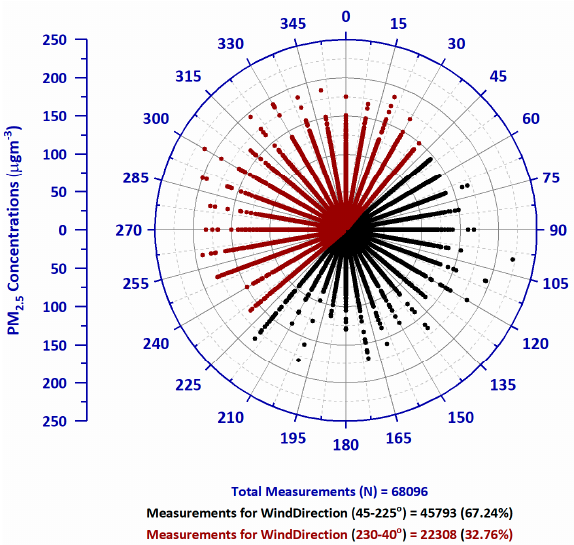
Figure 6. Hourly PM 2.5 concentrations from all air quality monitoring stations including Central, Tap Mun, Tsuen Wan, Yuen Long, and Tung Chung as a function of corresponding hourly surface wind direction in Hong Kong (2007–2008) . Table 5. Statistics of hourly PM 2.5 concentrations from all air quality monitoring stations, including Central, Tap Mun, Tsuen Wan, Yuen Long, and Tung Chung, as a function of corresponding hourly surface wind direction in Hong Kong (2007–2008) .